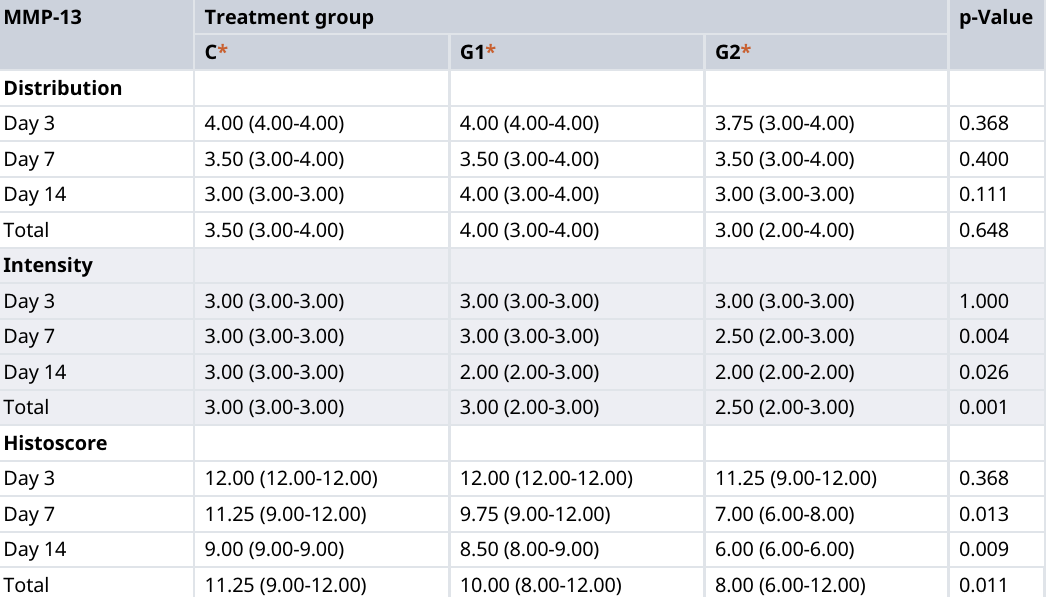
Table 1. Histoscore difference of MMP-13 between groups